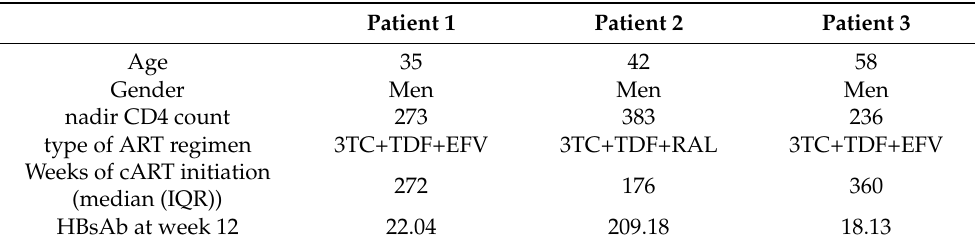
Table 2. Characteristics of participants who did not sustain protective HBV serological immunity at 102 weeks.